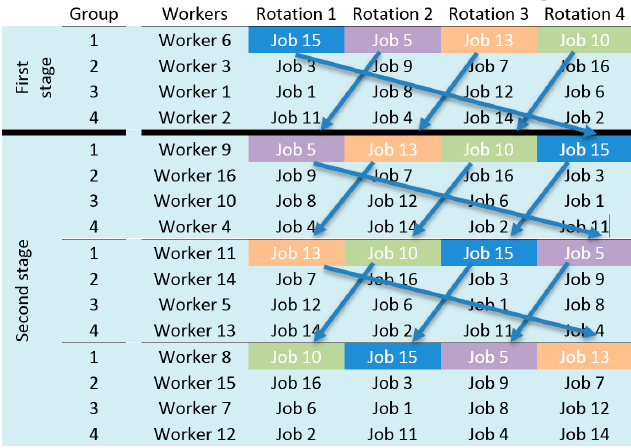
Figure 2. Solution encoding and procedure for the generation of individuals.